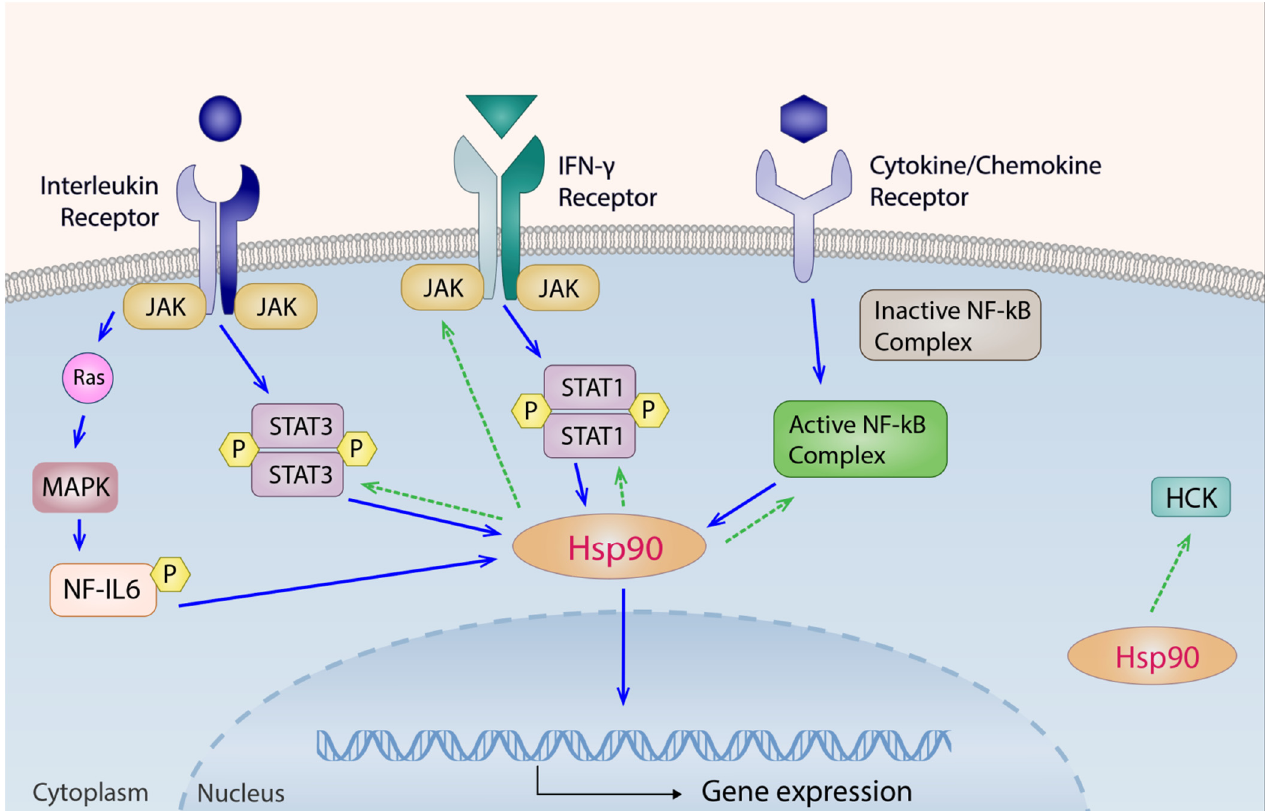
Figure 5. Signaling pathways of Hsp90 in the inflammatory process. Solid blue arrows indicate signaling pathways that upregulate Hsp90 expressions in the inflammatory process. IL-6 upregulates Hsp90 via both the JAK-STAT3 and the NF-IL6 pathways. INF- γ increases Hsp90 expressions through the JAK-STAT1 pathway. Other cytokines/chemokines such as TNF and IL-1 can upregulate Hsp90 by activating the NF-kB complex. Dashed green arrows denote relevant pathways influenced by Hsp90. Hsp90 binds and stabilizes JAK and STAT proteins, as well as the nonreceptor tyrosine kinase HCK, which is known to regulate innate immune response. Reciprocatively, Hsp90 is required to induce NF-kB. HCK, hematopoietic cell kinase; IL, interleukin; INF, interferon; JAK, Janus kinase; MAPK, mitogen-activated protein kinase; NF-kB, nuclear factor kappa-light-chain-enhancer of activated B cells; Ras, rat sarcoma protein, or Ras GTPase protein; STAT, signal transducer and activator of transcription.